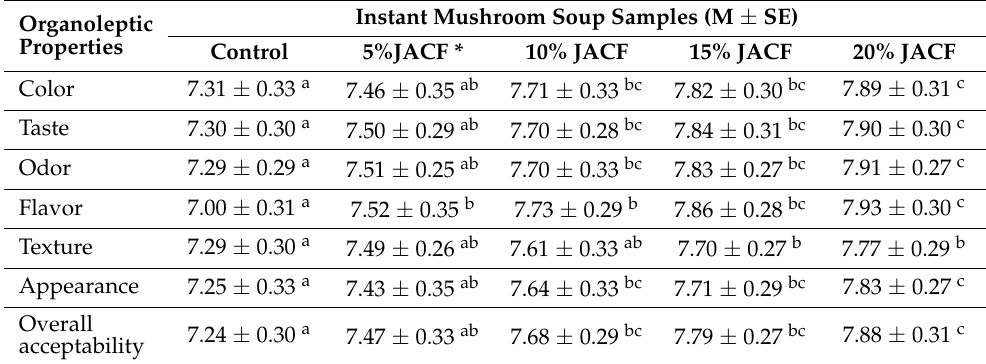
Table 8. Organoleptic properties of the instant mushroom soup